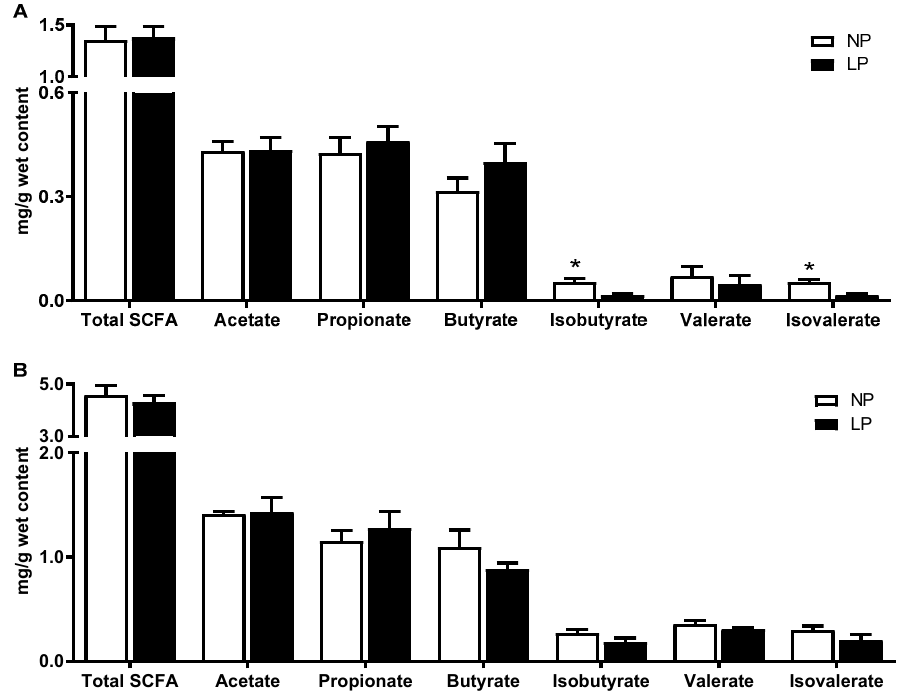
Figure 2. Effects of protein restriction and realimentation on SCFAs in colonic digesta of piglets at day 14 ( A ) and the end of the experiment ( B ). NP, normal protein group. LP, low protein group. * p -value < 0.05.